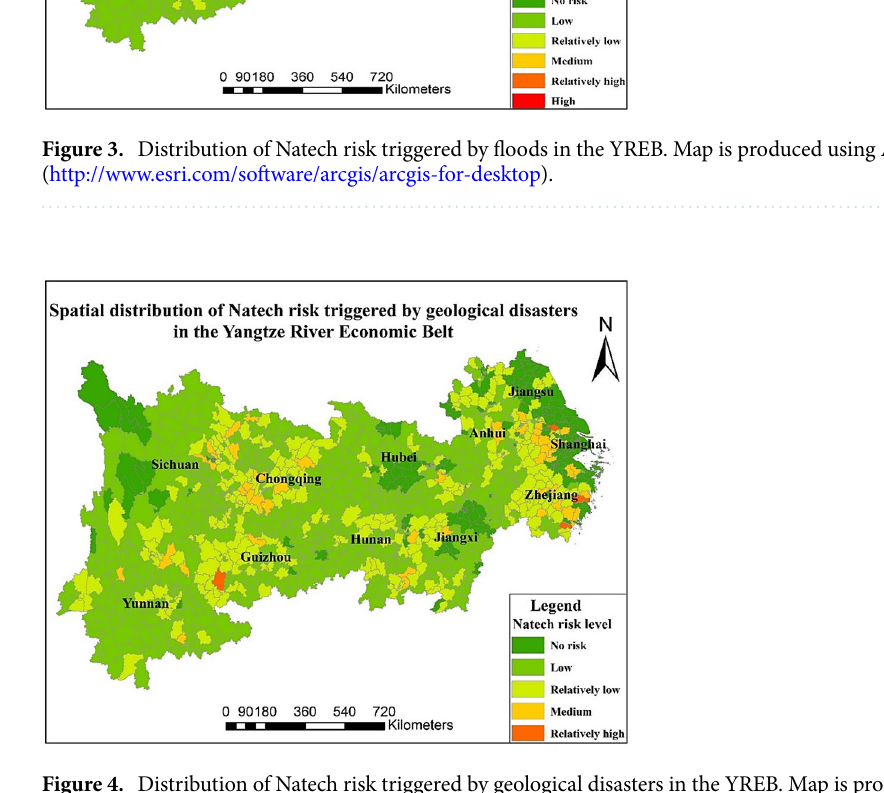
Zhejiang Province, Panzhou City of Guizhou Province, Jiangyin City of Jiangsu Province. The risk level of most districts and counties is low risk or no risk.